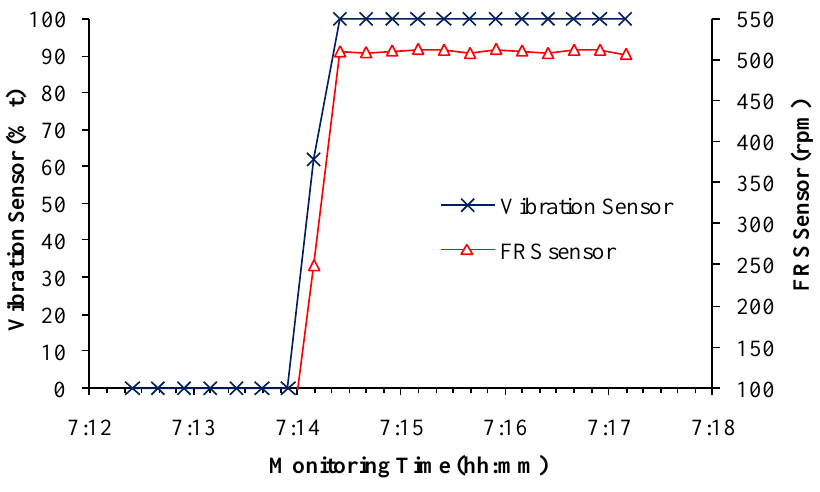
Figure 3. Comparison of responses between a vibration sensor and a FRS sensor of the same